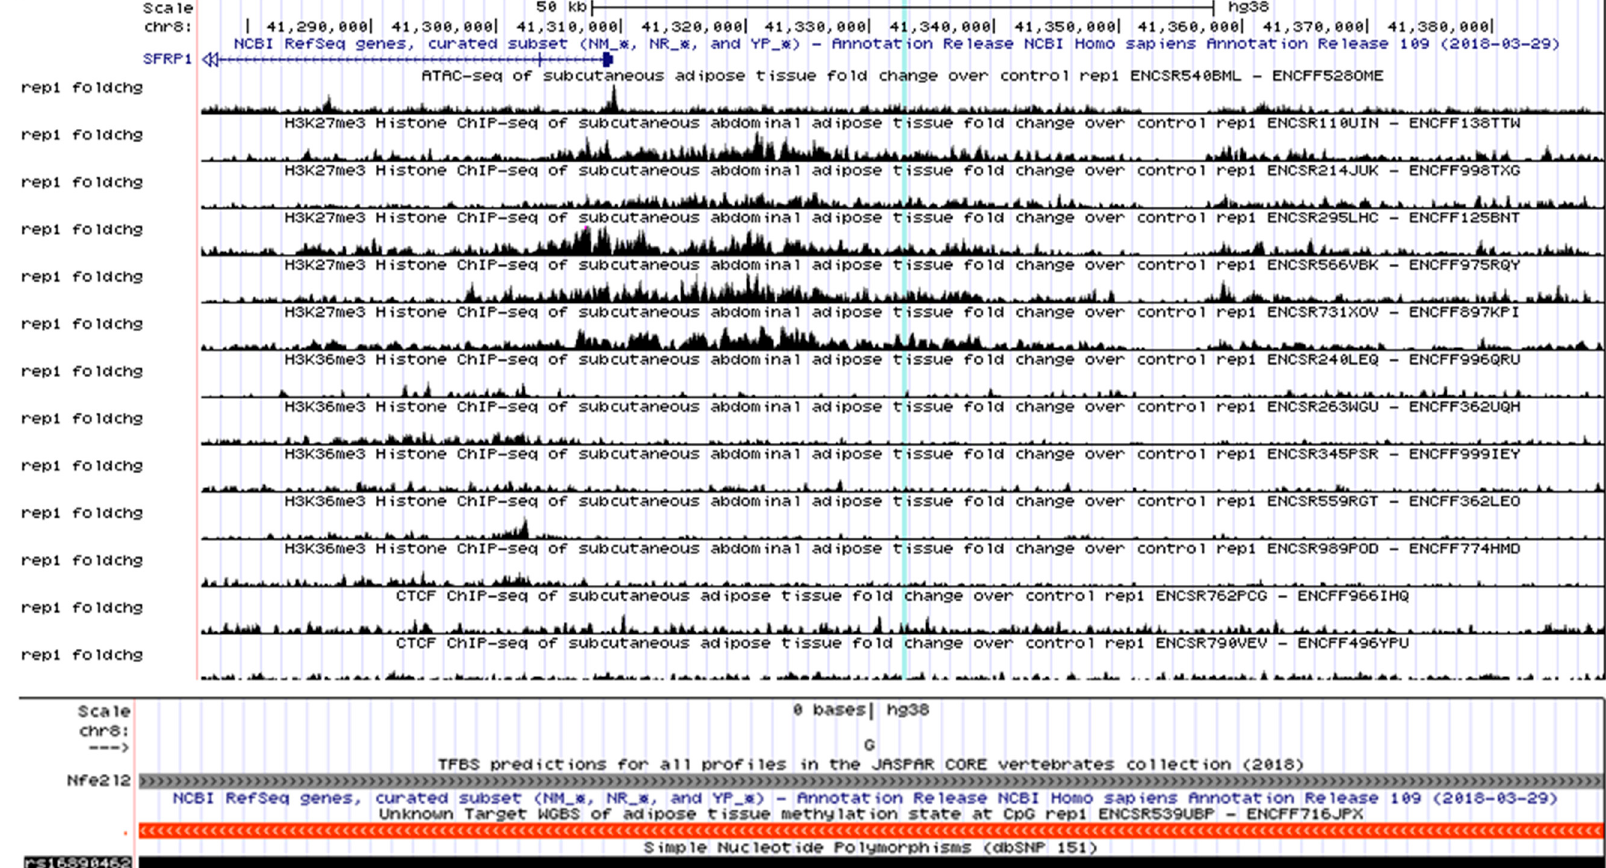
Figure 2. Regulatory features of SFRP1 locus - rs16890462. Gene regulatory signatures in human subcutaneous adipose tissue. H3K36me3: Active transcription; H3K27me3: Repressed transcription; ATAC-seq peaks: Open chromatin; CTCF: TF that is enriched in repressed genic regions [ENCODE data]. Predicted binding sites for TFs where gray scale denotes enrichment of TF [JASPAR data].